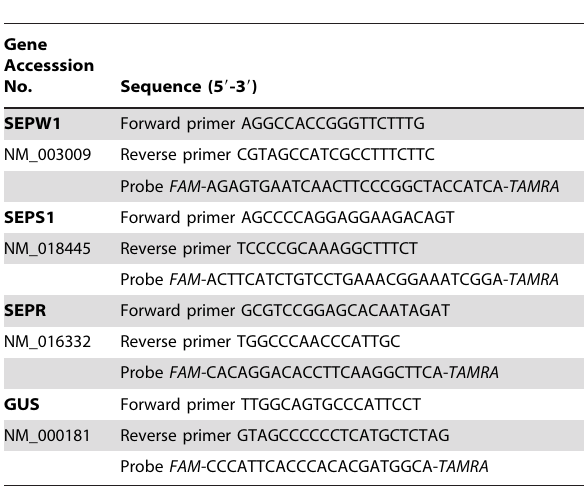
Table 1. Primer and probe sequences used for real-time reverse transcription PCR